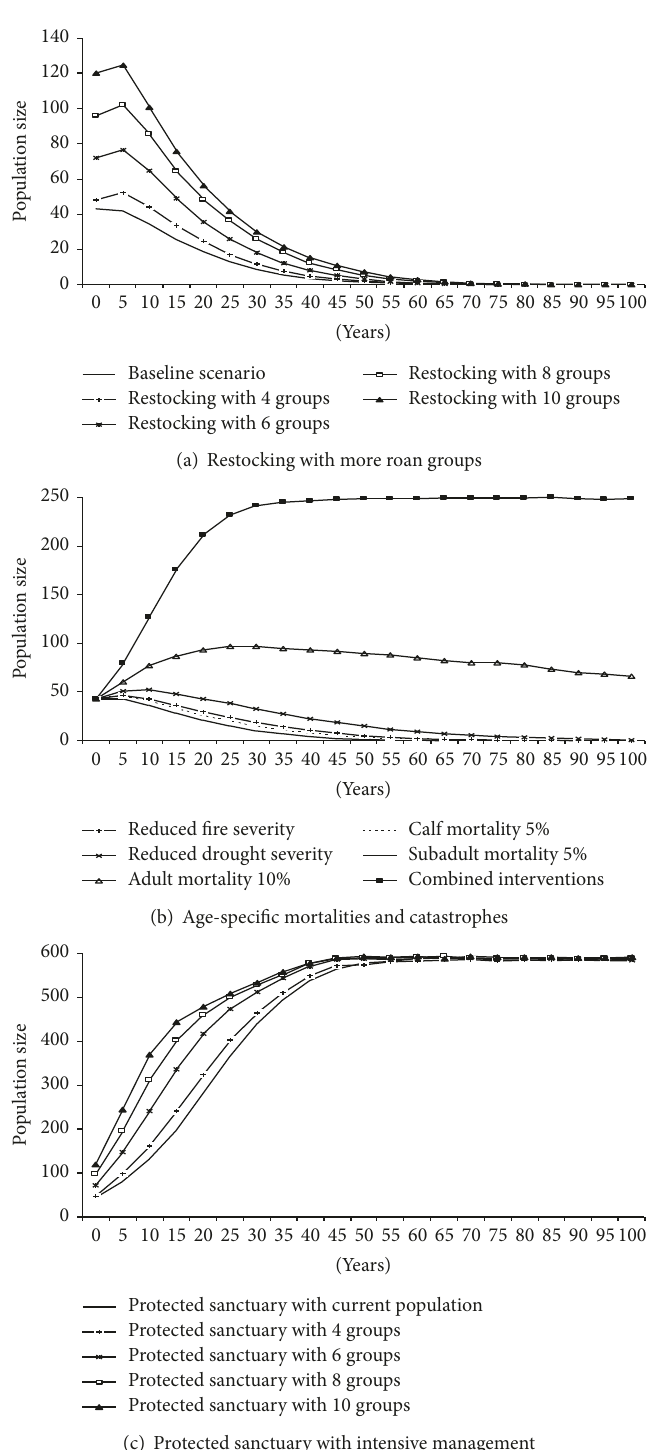
Figure 2: Mean population size for populations simulated over 100 years under alternative management options: (a) restocking; (b) reducing age-specific mortalities and catastrophes; and (c) establishing a roan sanctuary with intensive